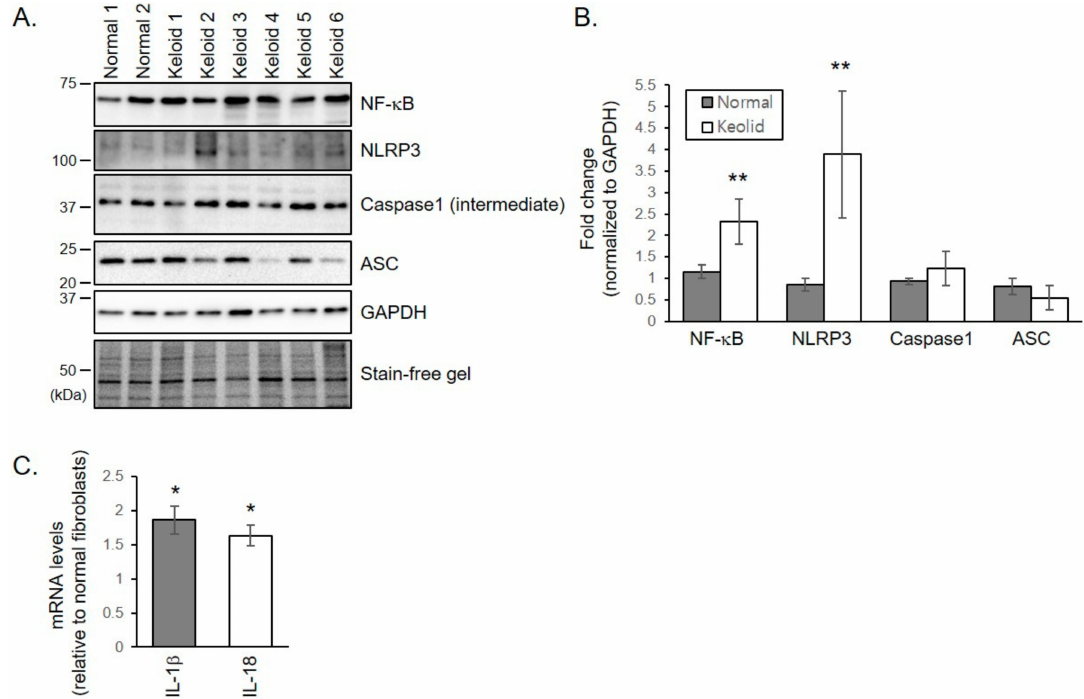
Figure 3. NLRP3 inflammasome formation is activated in keloid fibroblasts. ( A ) Normal and keloid fibroblasts were lysed and subjected to immunoblotting against NLRP3 inflammasome molecules. Gels are representative of five experiments. ( B ) Graphs represent means ± s.d. of five independent experiments. ( C ) mRNA levels of IL-1 β and IL-18 in keloid and normal fibroblasts were determined by quantitative real-time PCR. Graphs were drawn as the fold change in mRNA levels in keloids when the mRNA levels of normal fibroblasts were corrected to 1. Graphs represent means ± s.d. of three independent experiments. * p < 0.05; ** p <